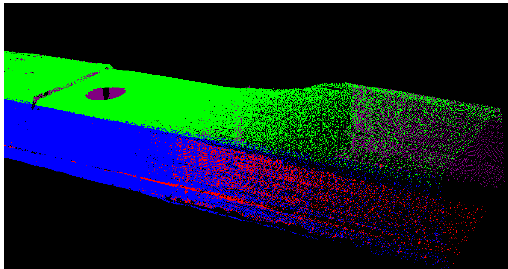
Figure 4. Point cloud data after resampled